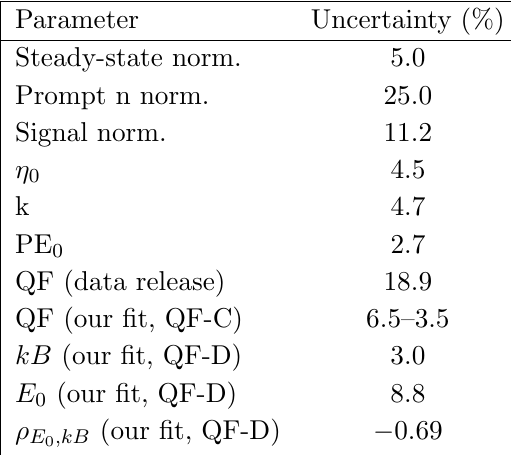
Systematic uncertainties considered in the (cid:12)t on acceptance e(cid:14)ciency parameters (eq. (3.5)), normalization of the signal and background contributions, and the QF. The steady- state normalization uncertainty includes the statistical error of the sample (AC data). The quoted uncertainties on the QF also includes the error on the light yield (0.14%), which is however sub- dominant. For details on the QF parametrization, see section